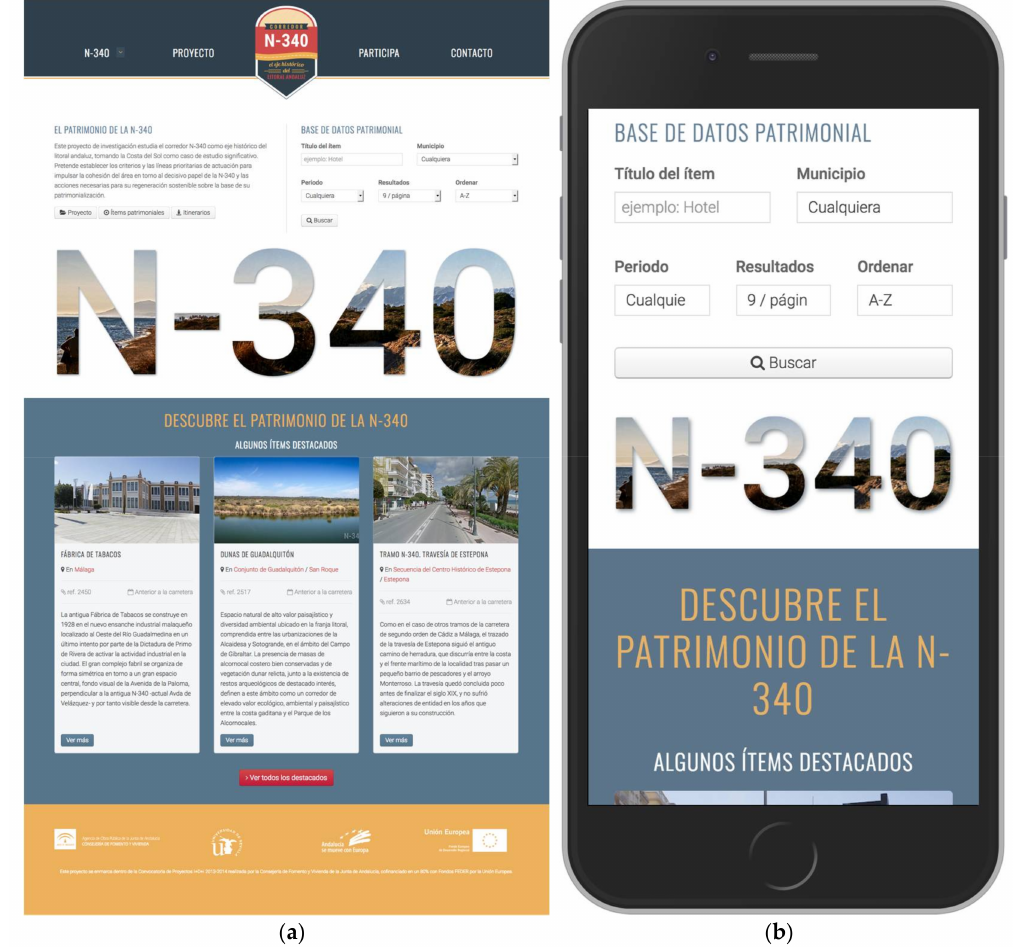
Figure 1. Project homepage: ( a ) as viewed on a desktop computer (https://n-340.org/); and ( b ) as viewed on a mobile phone (https://n-340.org/). Screenshots by the N-340 research team, January